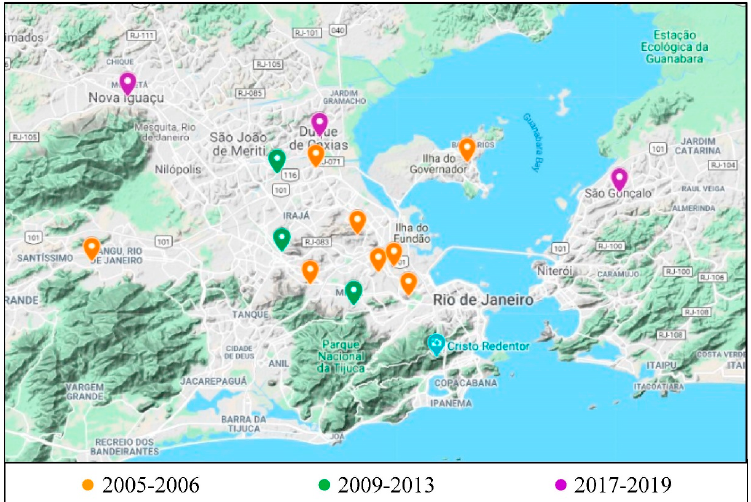
Figure 1. Locations of Trafficker Attacks.